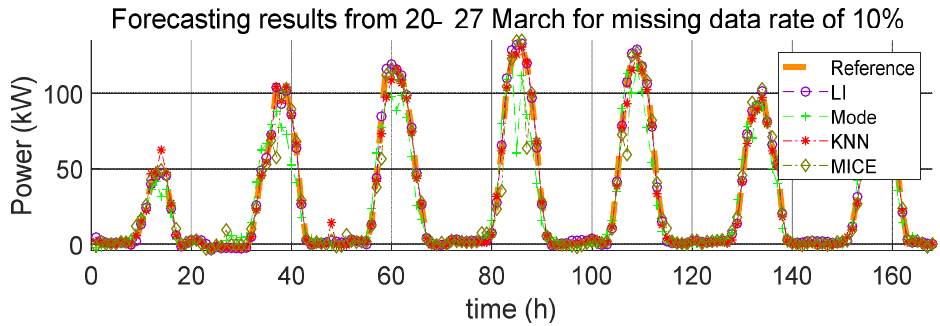
Figure 9. Forecasting results from 20 – 27 January for various missing data rates (10%, 15%, and 20%).